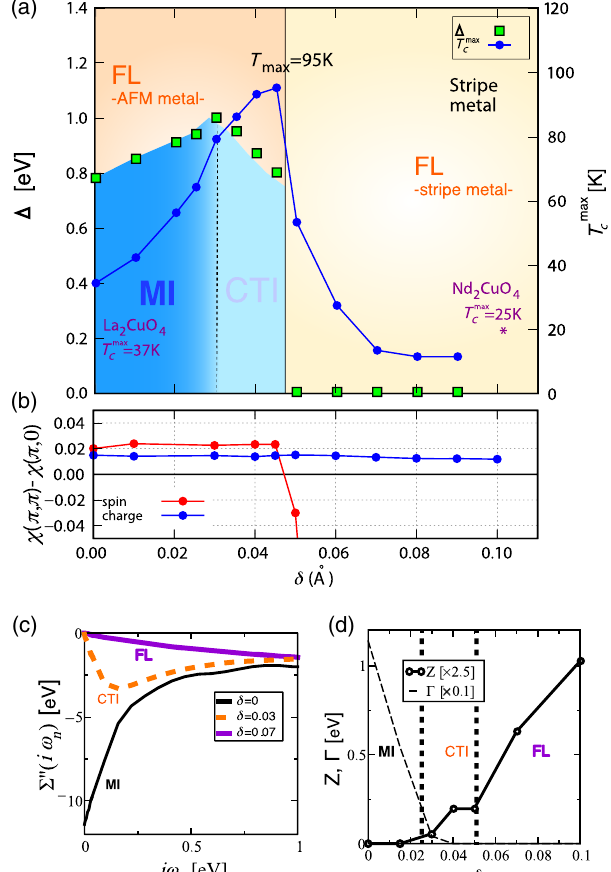
FIG. 1. Phase diagram. (a) Charge gap Δ (squares, left ordinates) with respect to δ , theapical oxygendisplacement.We show also the estimated critical temperature at optimal doping T max c (circles, right ordinates). We find that optimum critical temperature is largest at the insulator to metal transition ( δ ¼ 0 . 045 Å). (b) Relative static susceptibilities χ ð π ; π Þ - χ ð π ; 0 Þ for spin (blue circles) and charge (red circles) degrees offreedom. (c) Imaginary part of the Cu d x 2 − y 2 self-energy Σ 00 ð i ω Þ on the Matsubara axis for pristine LCO (bold line) and distorted LCO. For ω < 0 . 03 , the self-energy is extrapo- lated with a polynomial fit to ω ¼ 0 . The large scattering rate and the pole in the self-energy for δ < 0 . 02 indicate a Mott insulating phase (MI), whereas for δ > 0 . 03 Å, we obtain a charge transfer insulator (CTI) with nonquadratic self-energies. (d) Imaginary part of the self-energy extrapolated to zero frequency Γ ¼ − Σ 00 ð i ω → 0 Þ and quasiparticle weight